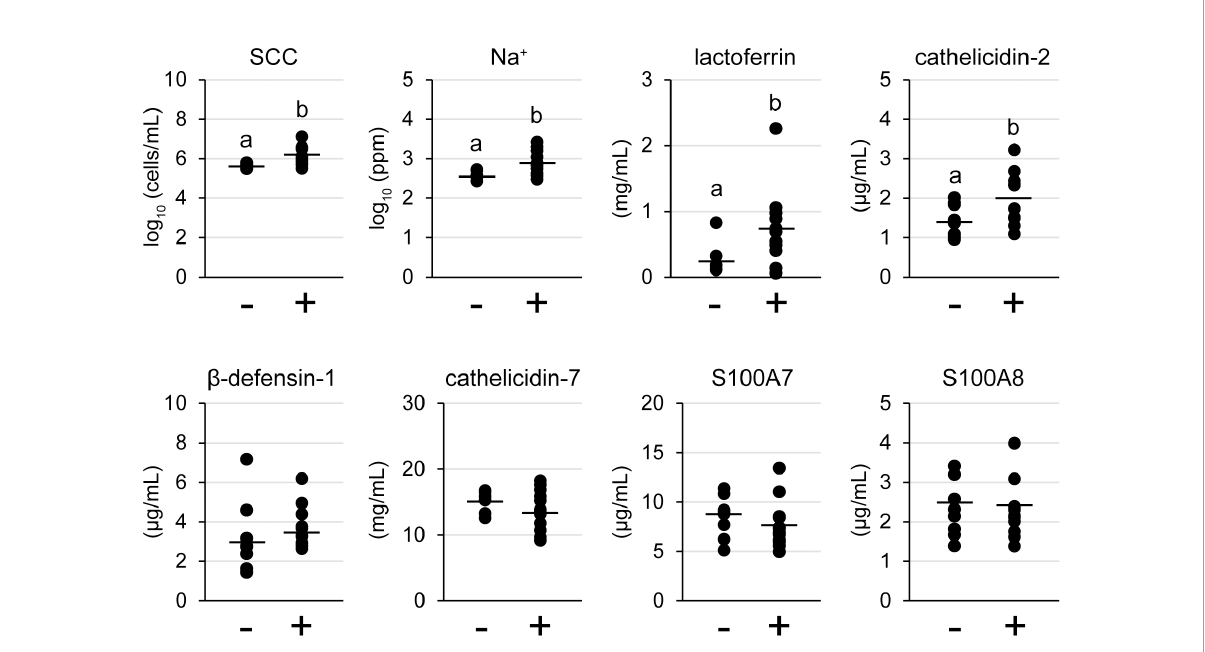
FIGURE 6 Somatic cell count (SCC), Na + , and antimicrobial components in tertiary lymphoid organ-positive and -negative goat milk. ( − ) lymphocyte aggregation-negative group; (+) lymphocyte aggregation-positive group. Different letters indicate a signi fi cant difference between groups (p <